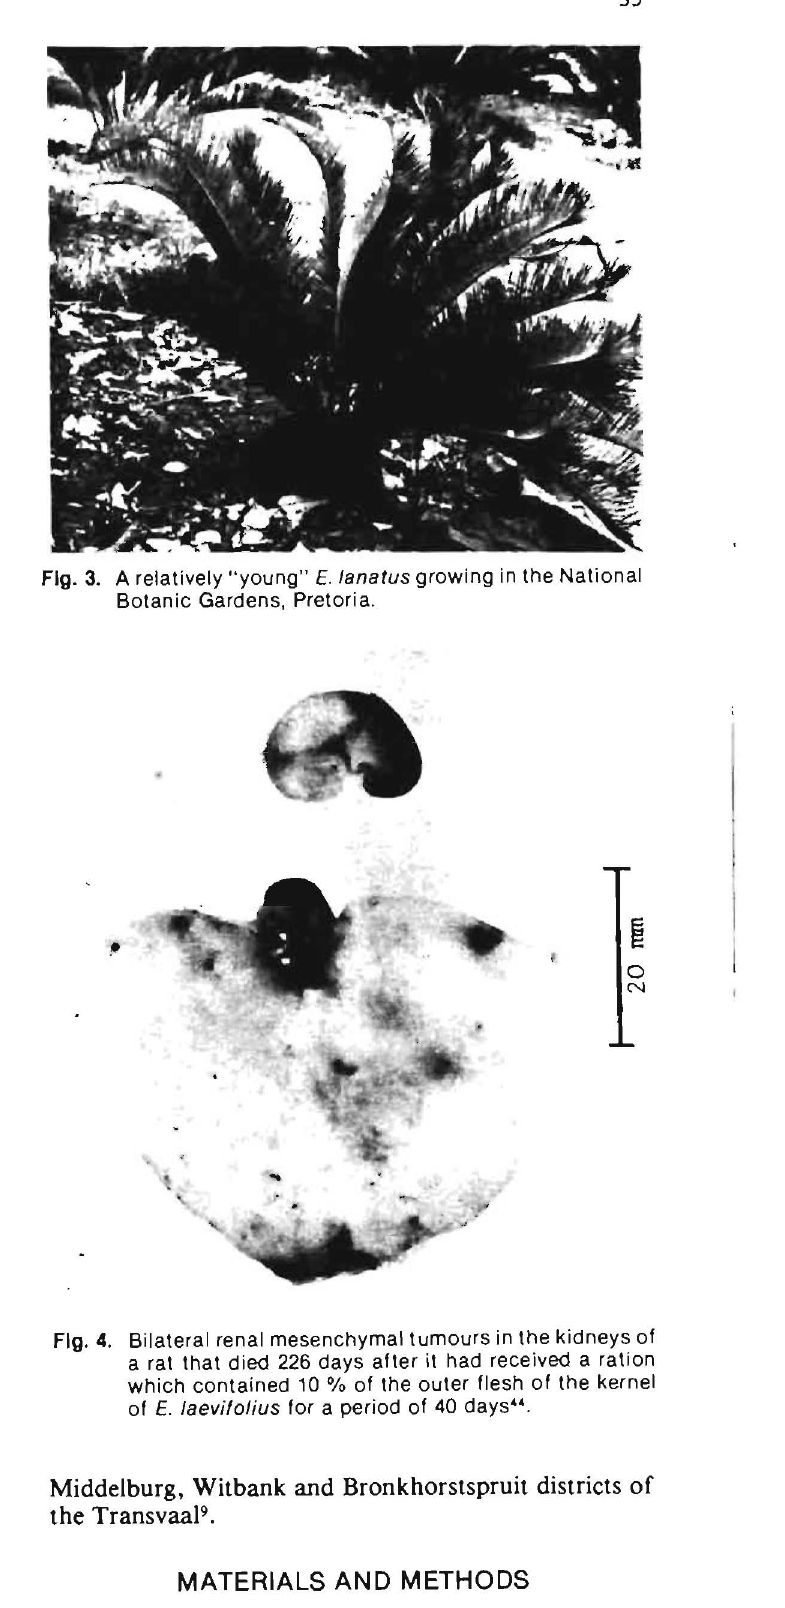
Fig. 4. Bilateral renal mesenchymal tumours in the kidneys of a rat that died 226 days after it had received a ration which contained 10 % of the outer flesh of the kernel of E. laevifolius for a period of 40